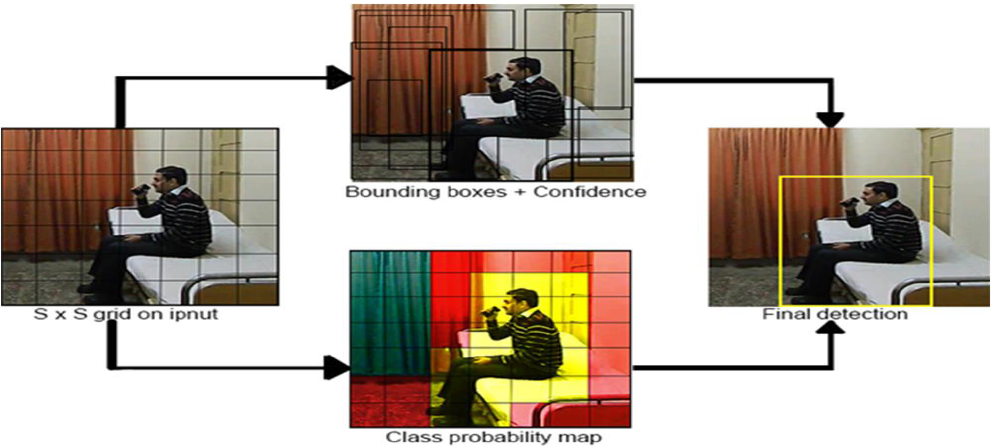
Figure 4. The system model divides the image into an S × S grid size and along with each grid cell B bounding boxes are predicted with confidence across those boxes, as well as C class